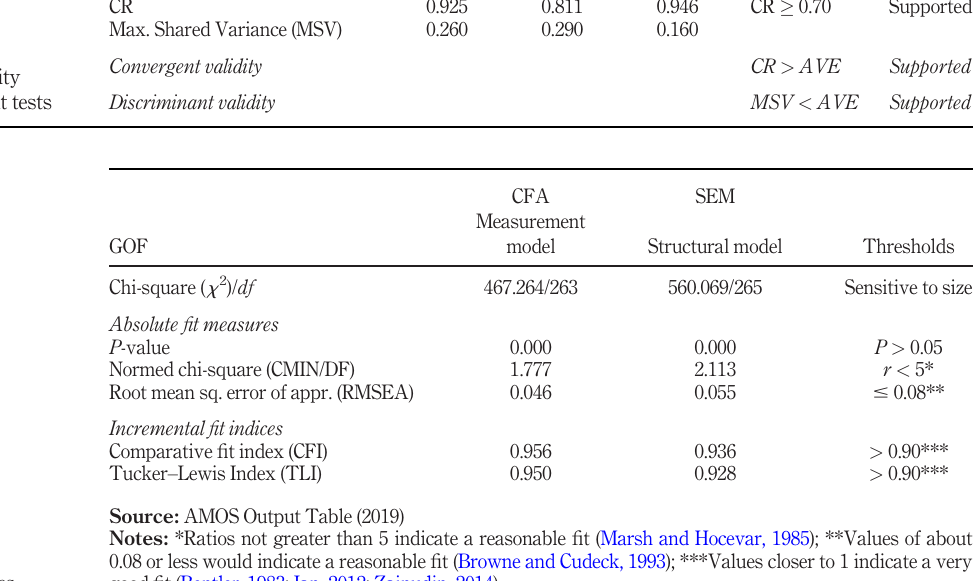
Table III. CFA validity assessment tests